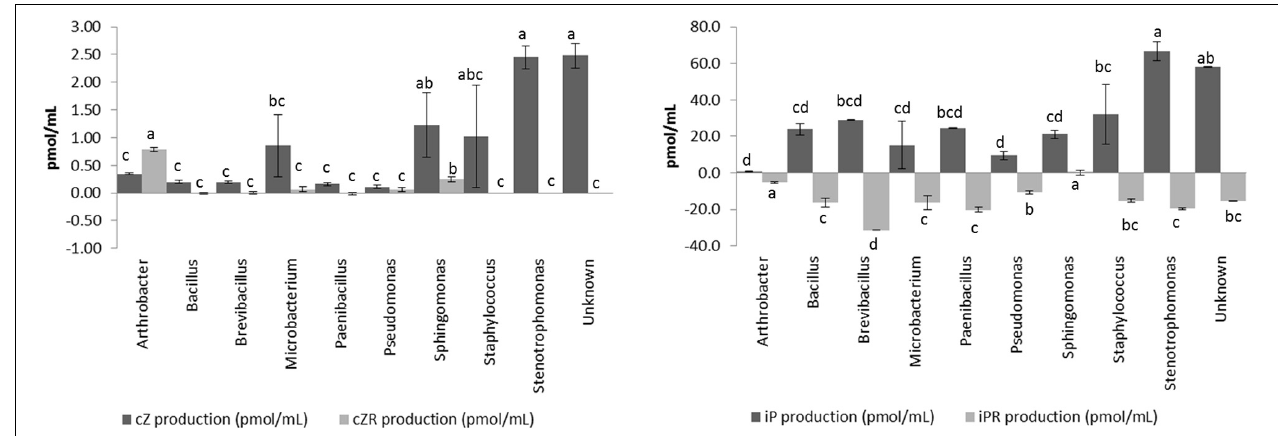
FIGURE 4 | Production of cytokinins (cZ, cZR, iP, and iPR) by endophytic isolates according the genus. Cytokinin production was measured in pmol per mL after 20 h of growth at 28 ◦ C in LB medium supplemented with 5 mM L-Tryptophan. Production was measured in triplicates for each isolate, and the final concentration was obtained after standardization. Bar errors represents the standard error. Letters represents the significant groups after ANOVA and HSD Tukey post-hoc tests. Signification threshold: p ≤